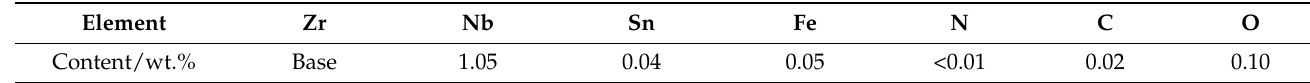
Table 1. Chemical composition of the studied material. Element Zr Nb Sn Fe N C O Content/wt.% Base